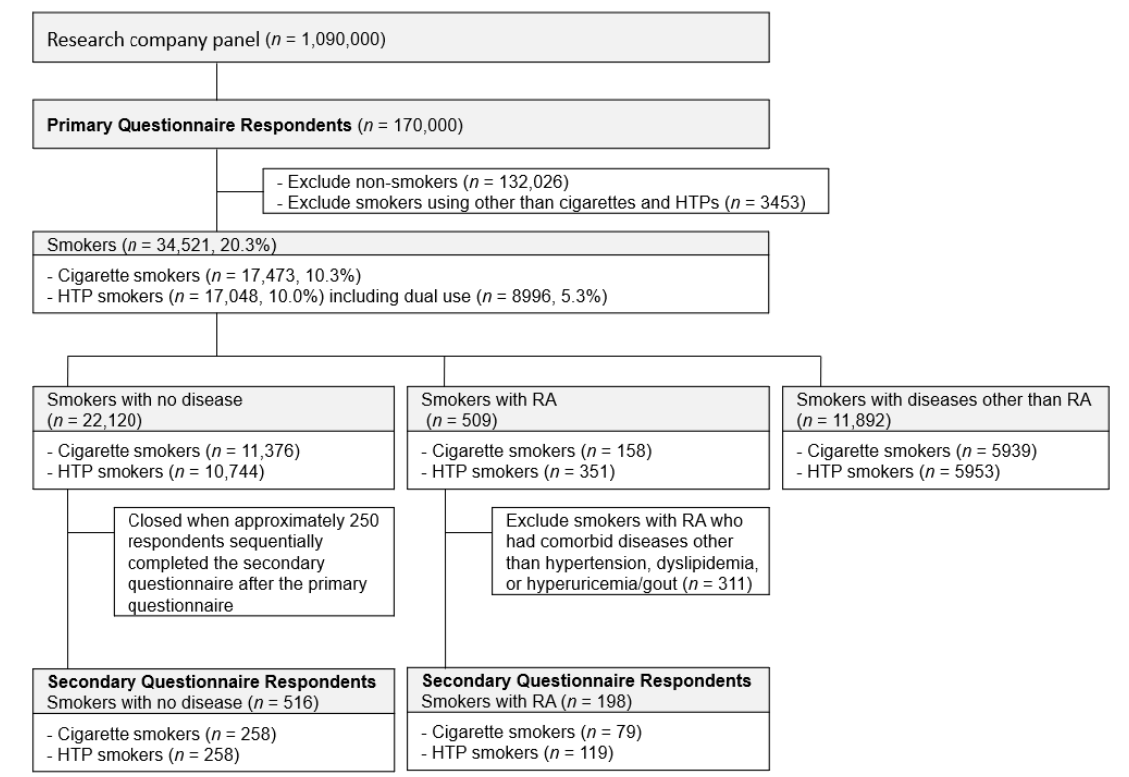
Figure 1. Study participants. A total of 170,000 respondents from 1,090,000 panelists completed the primary questionnaire. A total of 516 smokers with no disease and 198 smokers with RA sequentially completed the secondary questionnaire. HTP: heated tobacco product, RA: rheumatoid arthritis.